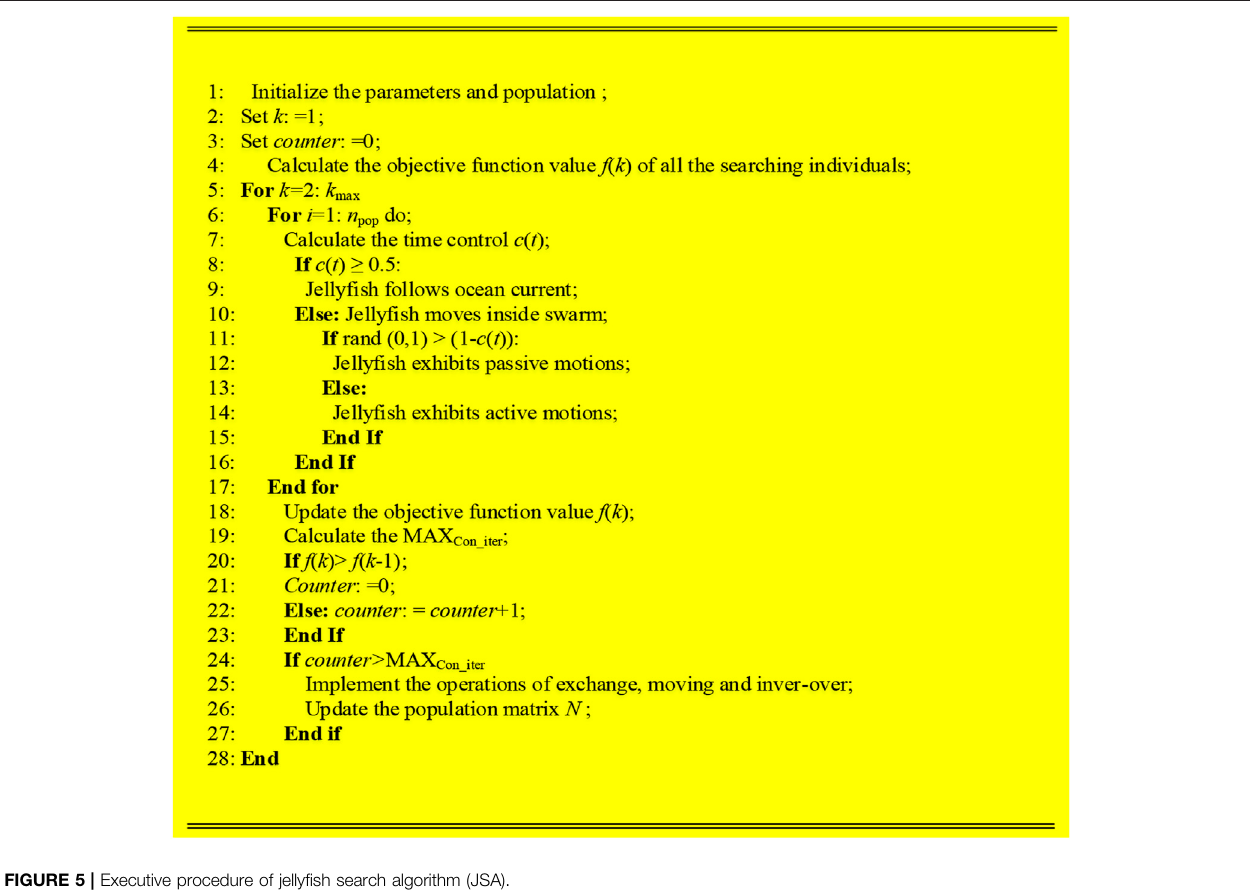
FIGURE 5 | Executive procedure of jelly fi sh search algorithm